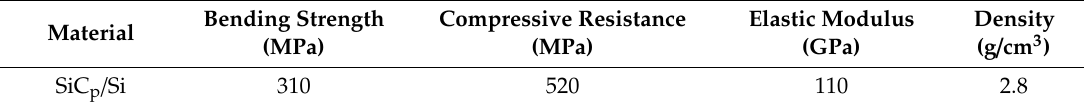
Table 5. Measured mechanical properties for the SiC p / Si composite material.